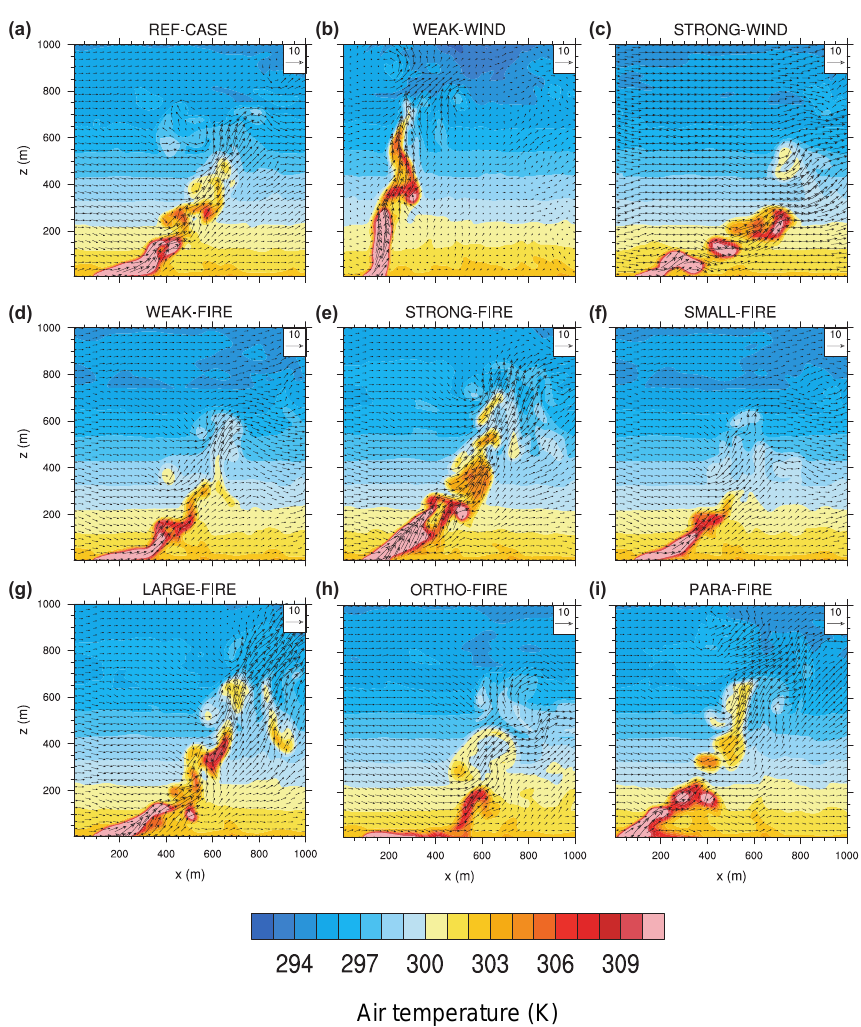
Figure 5. Vertical cross sections of the wind vector and air temperature fields through the fire center ( y = 600m) 20min after fire